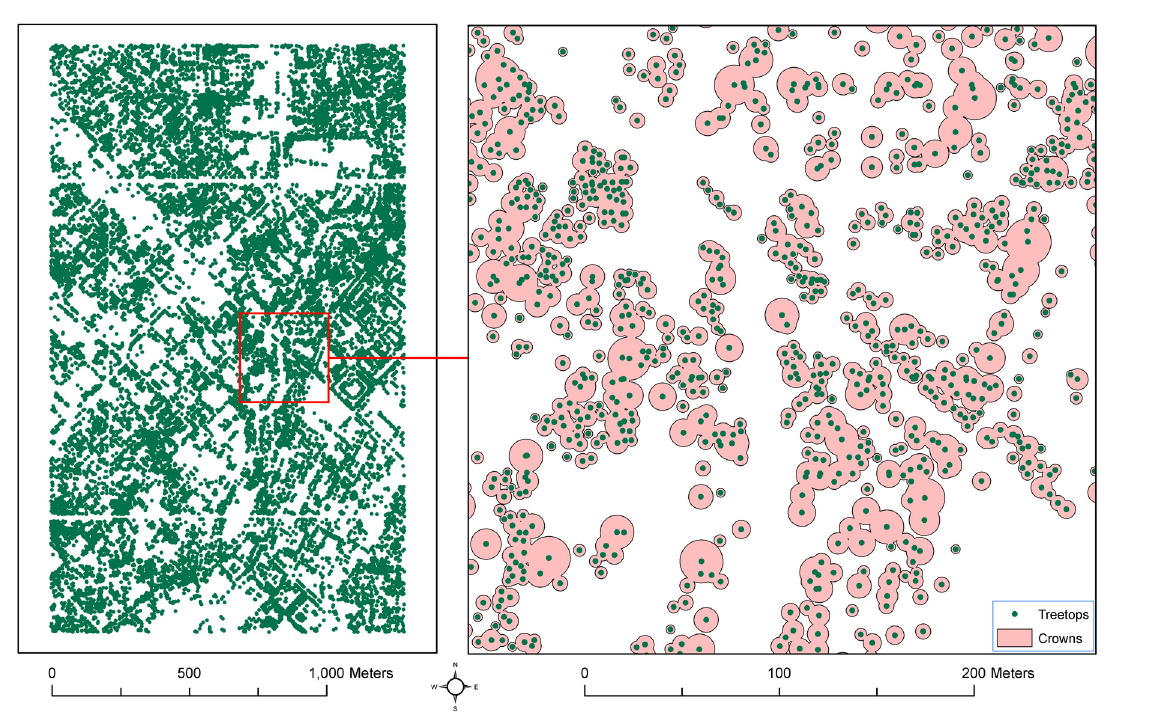
Figure 6. Detected trees shown in green dots for the study area ( left ) and delineated crowns for a zoomed region ( right